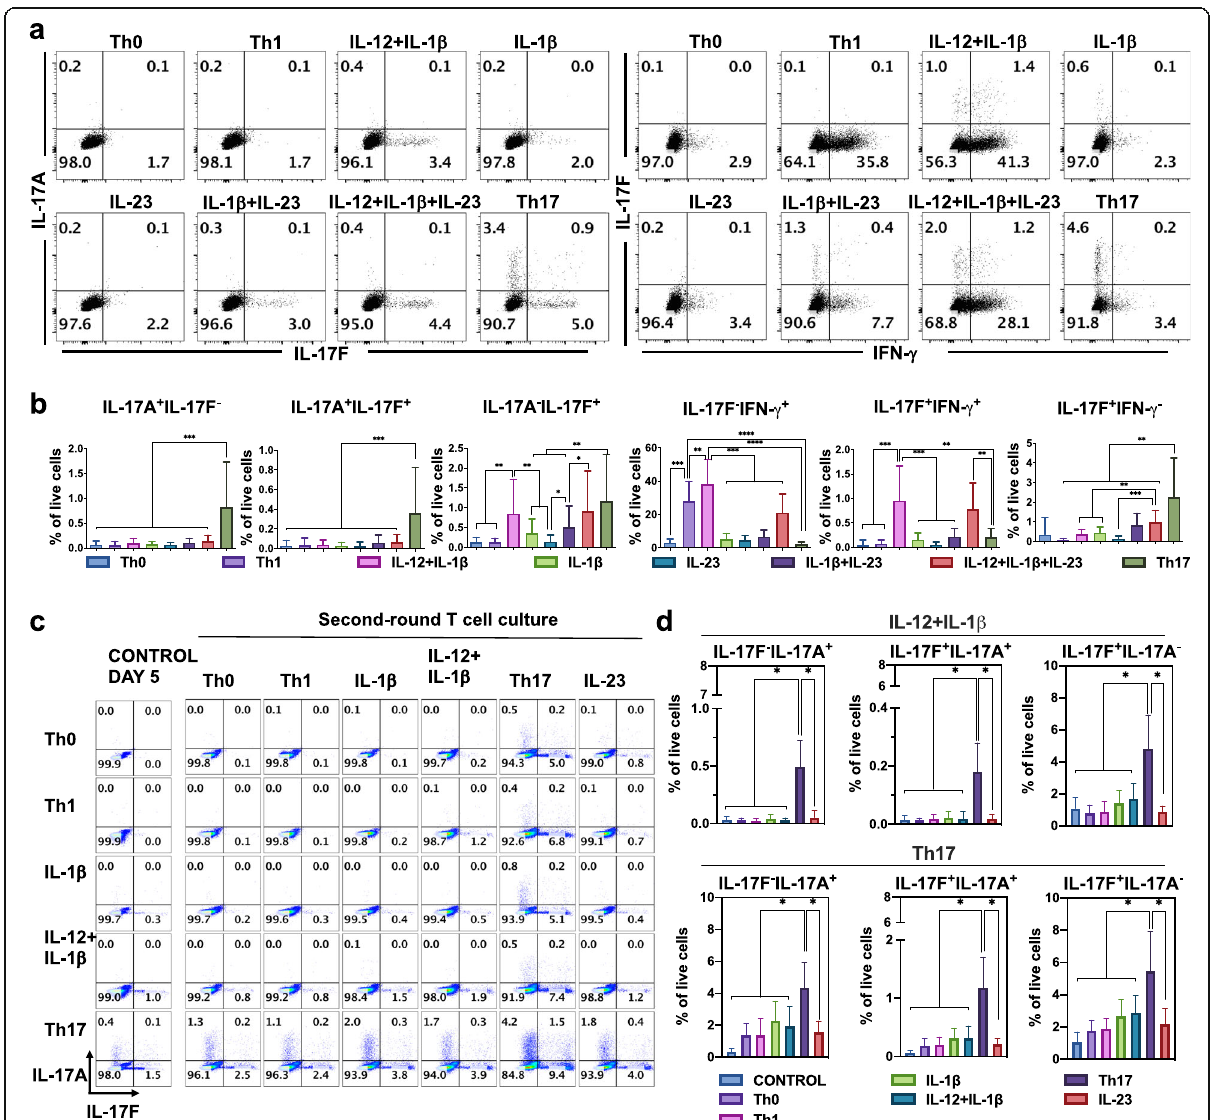
Fig. 4 Experimental validation of CD4 + T cell phenotypes. Human naive T cells were differentiated for 5 days in the presence of polyclonal activation (anti-CD3/anti-CD28 beads). Cells were cultured in the presence of different cytokine inputs: proTh1 (IL-12), IL-1 β , IL-23, IL-12+ IL-1 β , IL- 1 β + IL-23, IL-12 + IL-1 β + IL-23, proTh17 (IL-1 β + IL-6 + IL-23 + TGF- β ). Cells exposed only to polyclonal stimulation were considered as Th0. Differentiated cells were then subjected to flow cytometry analysis. a Dot plots representing the IL-17A and IL-17F cells in live CD4 + cells are shown on the left. Dot plots representing the IL-17F and IFN- γ cells in live CD4 + cells are shown on the right. Representative data from three independent experiments are shown. Numbers denotes frequency of gated cells. b The frequency of cells for each subset in Apannel a is shown. Graphs represent mean ± SD, N = 12, *, ** and *** denotes p < 0.05, p < 0.01 and p < 0.001, respectively (Wilcoxon test). c Cells were submitted to a second round of polarization in the presence of the cytokine inputs: IL-1 β , IL-12, IL-23, IL-12 + IL-1 β , proTh17, for two additional days. Dot plots representing the IL-17A and IL-17F cells in live CD4 + cells and frequency of cells are shown. d The frequency of cells for each subset in Cpannel c is shown. Graphs represent mean ± SD, N = 6, * represents p < 0.05 (Wilcoxon